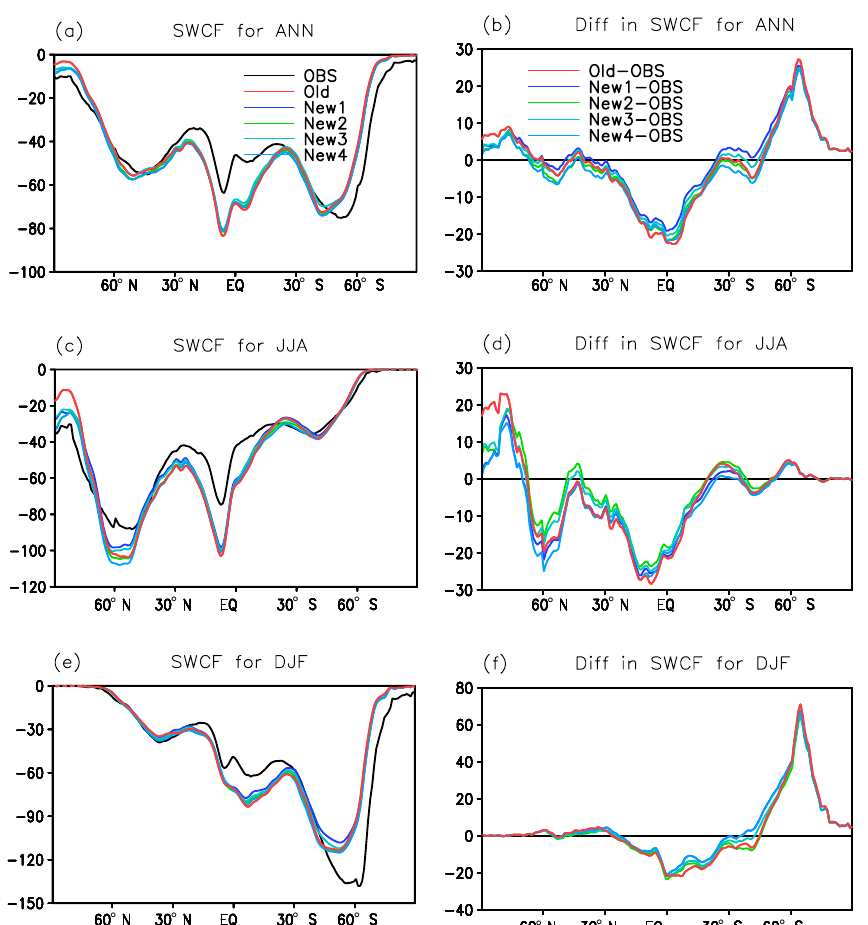
Figure 2. Annual, JJA, and DJF zonal mean of shortwave cloud radiative forcing (SWCF, Wm − 2 ) derived from CAM5.1 ( a , c , and e ) and the CERES-EBAF observations (OBS), and their difference between OBS and Old, as well as News ( b , d , and f